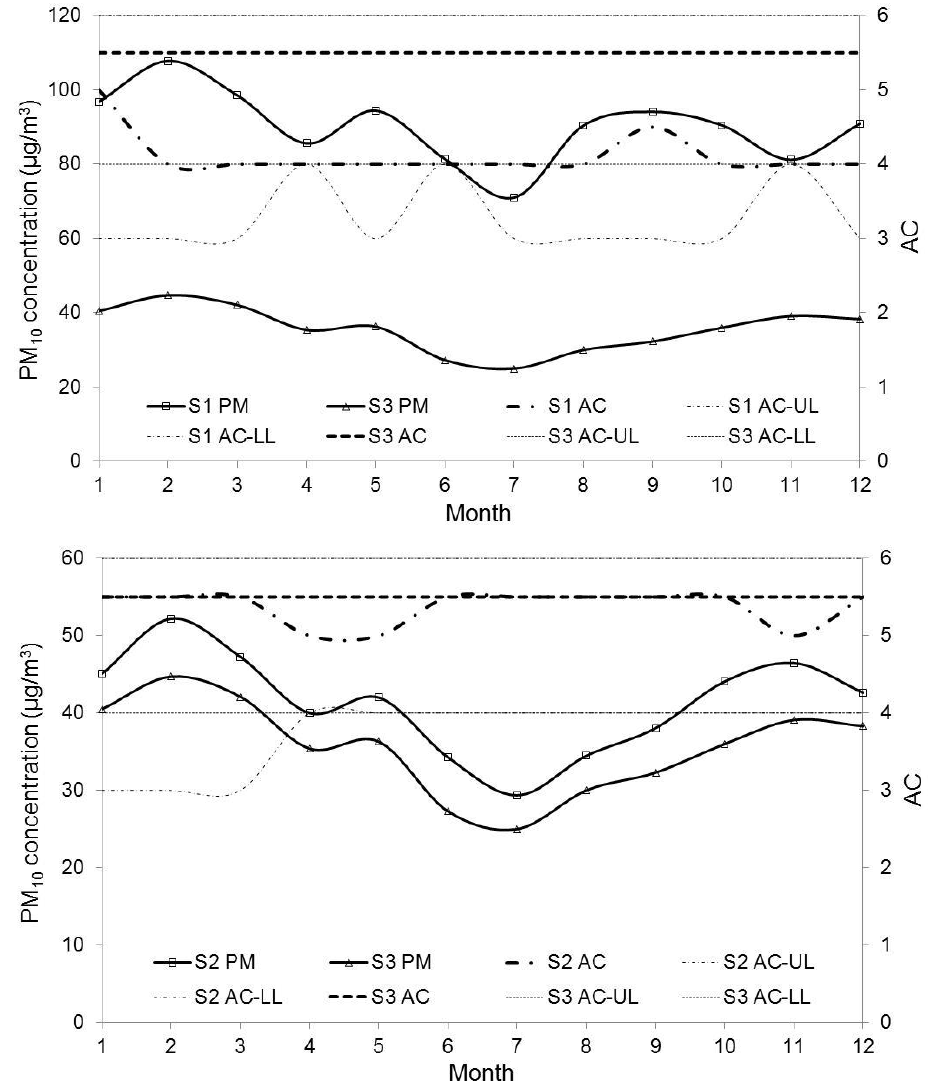
Figure 6. Monthly comparison between DPM 10 and daytime AC. Month: 1 = January, 2 = February, 3 = March, 4 = April,